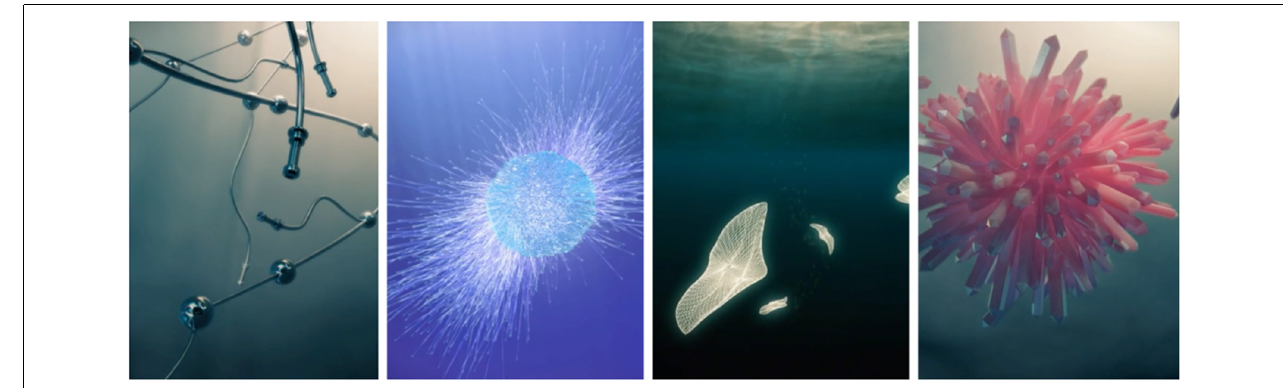
FIGURE 1 | Still-shots from the InScapes